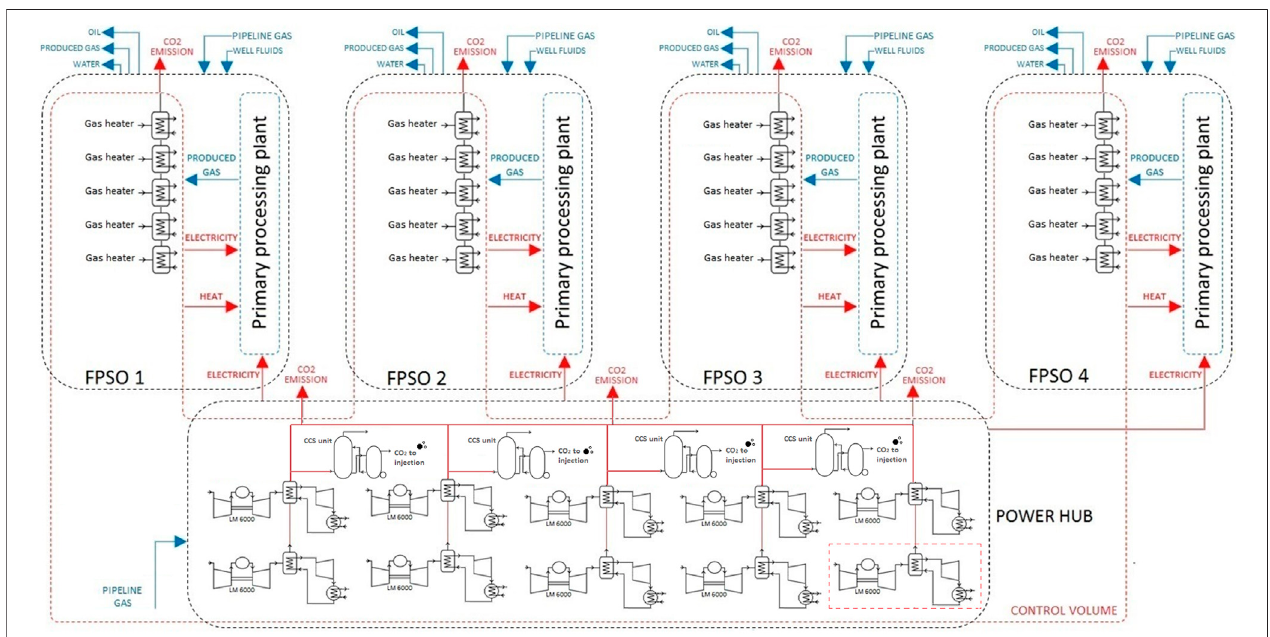
FIGURE 2 | Power hub conceived for supplying the electricity to four productive FPSOs with identical energy